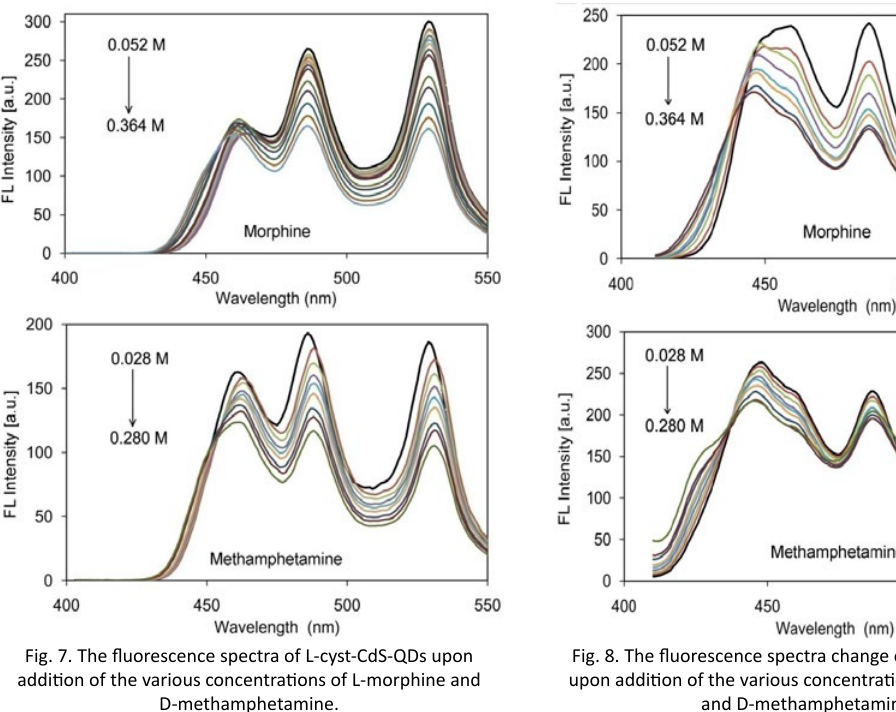
329 J Nanostruct 8(4): 325-331, Autumn